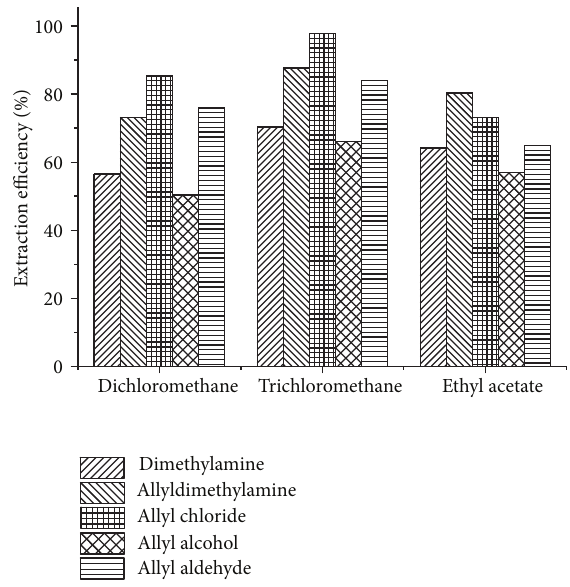
Figure 5: Effect of DADMAC concentration on the peaks of analytes.